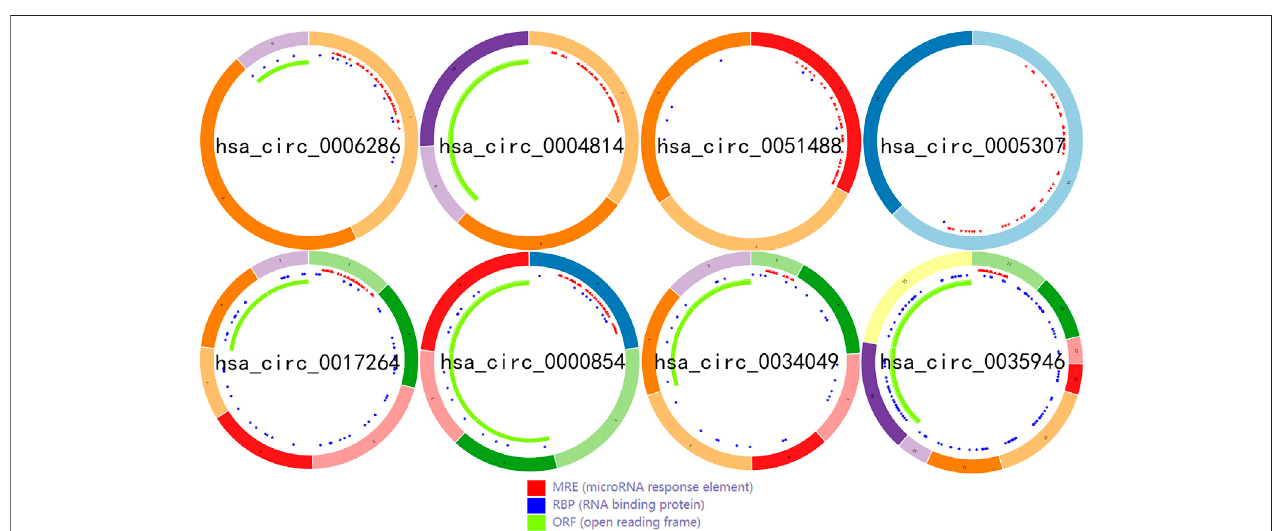
FIGURE 2 | The structural patterns of the top upregulated circRNAs from the CSCD.